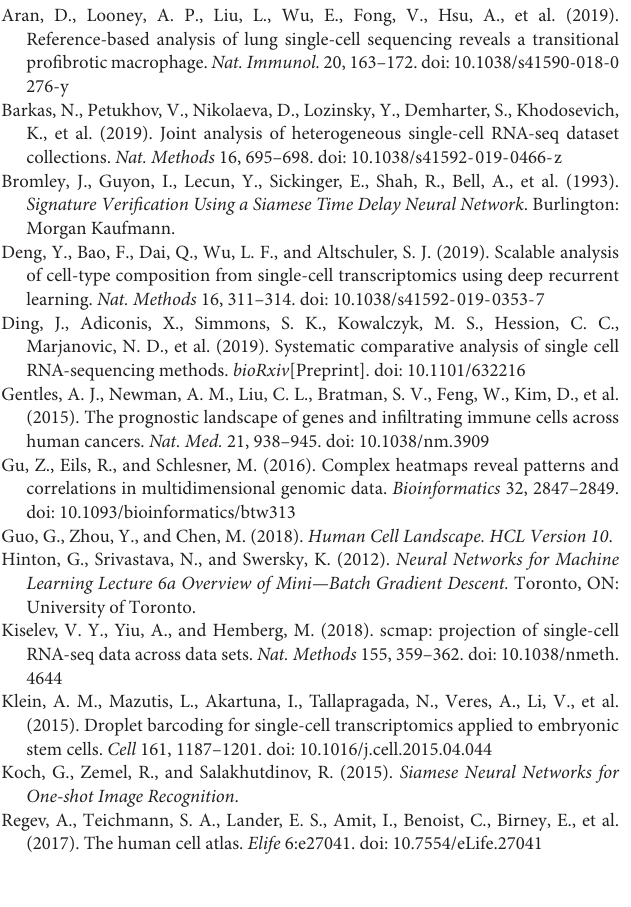
Supplementary Figure 1 | Visualization of training phase of Siamese Neural Network (SNN). (Top Row) Umap visualization of the embedding space projection in the last neuronal output at different training epochs. Example cell types that are better resolved, as measured by increased spatial separation in the embedding space over increasing training epochs, are indicated with arrows. (Bottom Row)